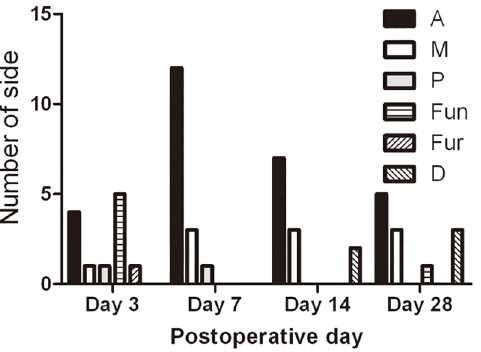
Fig 5. Different types of capsular bends at various times after surgery. A = anterior adhesion type, M = middle adhesion type, P = posterior adhesion type, Fun = funnel adhesion type, Fur = furcate adhesion type, and D = detachment type.